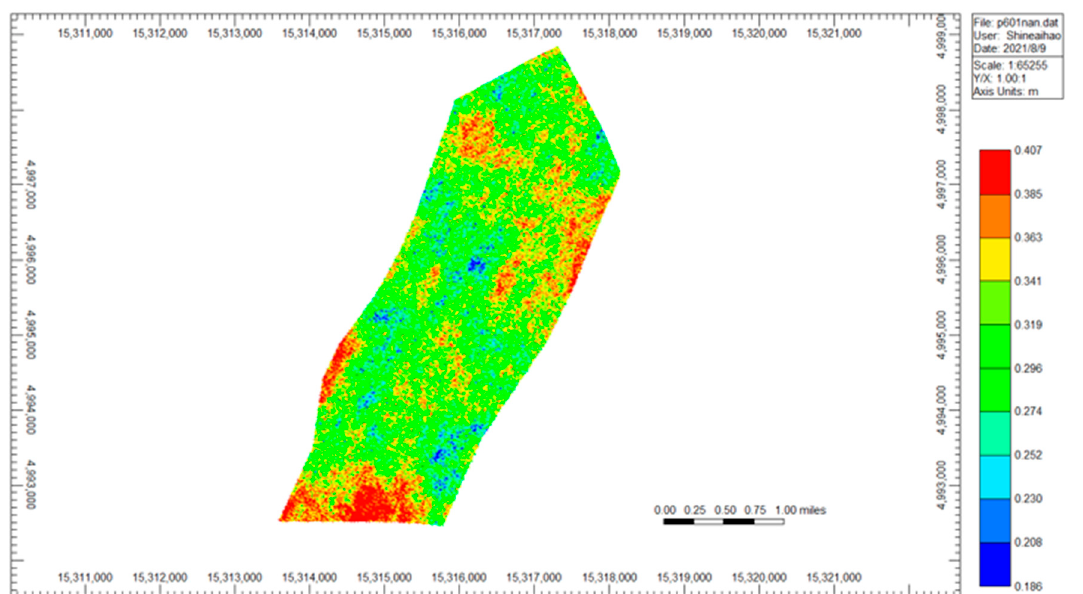
Figure A4. Porosity of numerical simulation model.